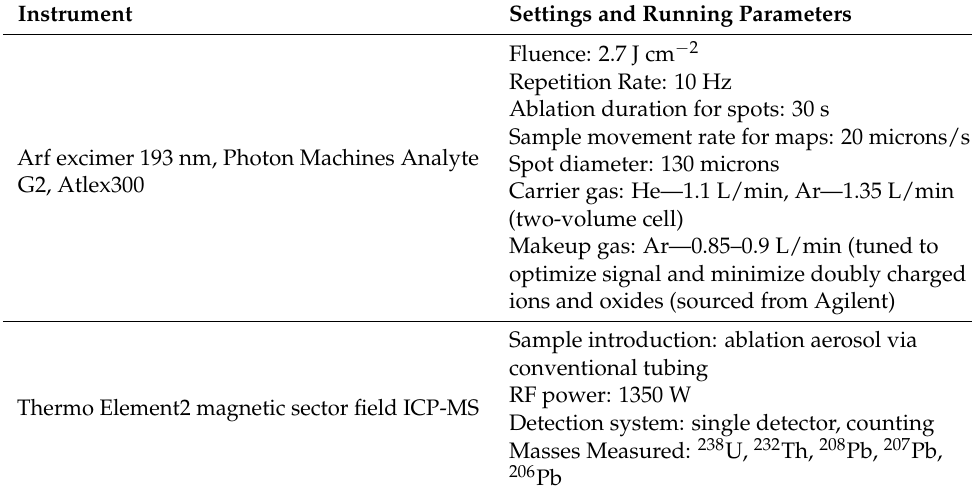
Table 2. Laser ablation instruments and parameters used in this study (University of Kansas).